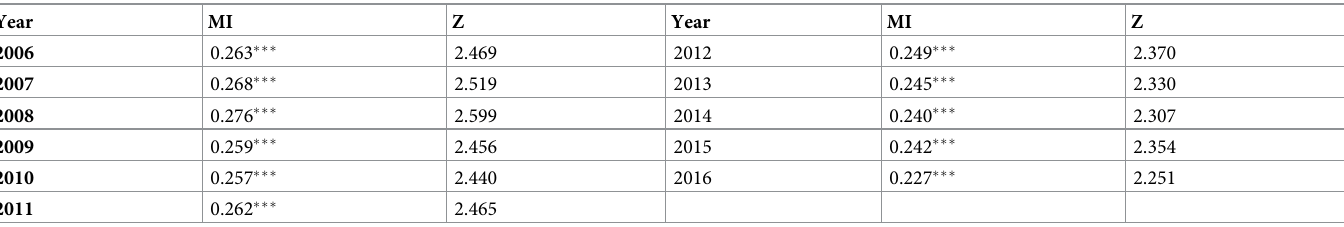
Table 7. Moran’s Index of CO 2 emission.